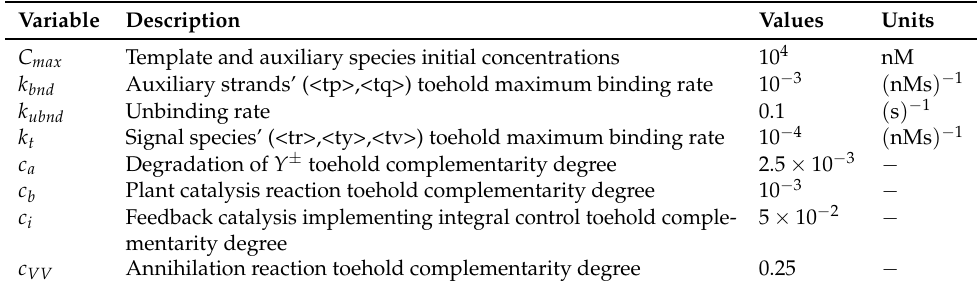
Table 1. The integral control circuit’s parametrisation for Visual DSD